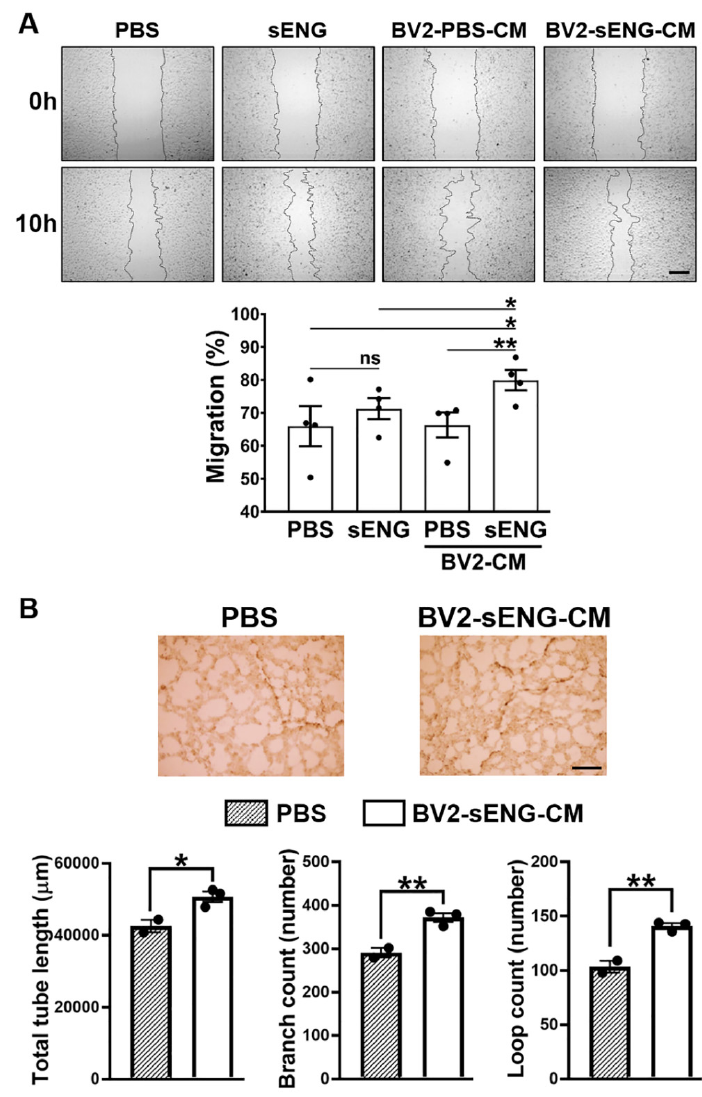
Figure 5. Soluble ENG-stimulated microglia induces a hyper-angiogenic phenotype of endothelial cells. ( A ) BV2-sENG-CM induced EC migration in a scratch-wound assay. The rate of EC migration in